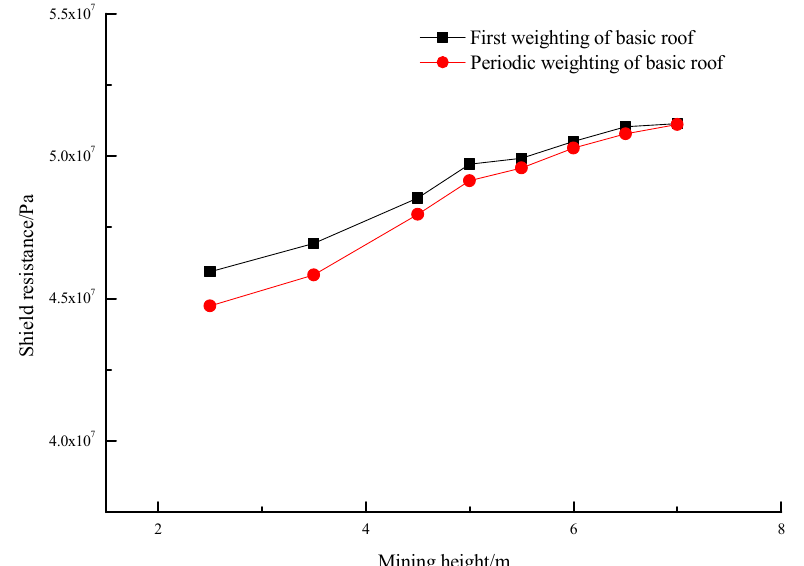
Figure 14. Average shield resistance for different mining heights during the first and periodic weighting of basic roof.